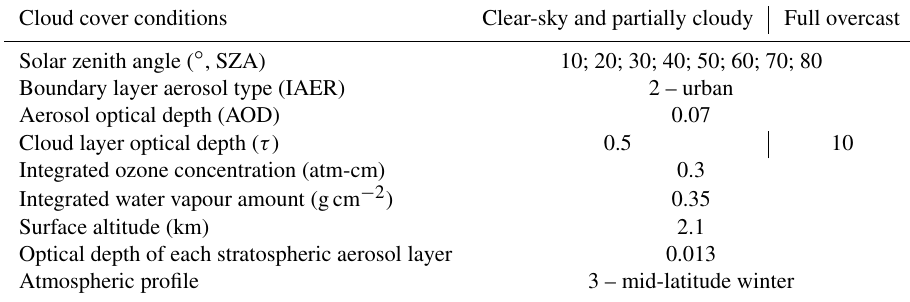
Table 1. Atmospheric parameters of reference irradiance profiles. Each irradiance profile is calculated for eight values of SZA and two values of τ . The other parameters are fixed in the SBDART model.